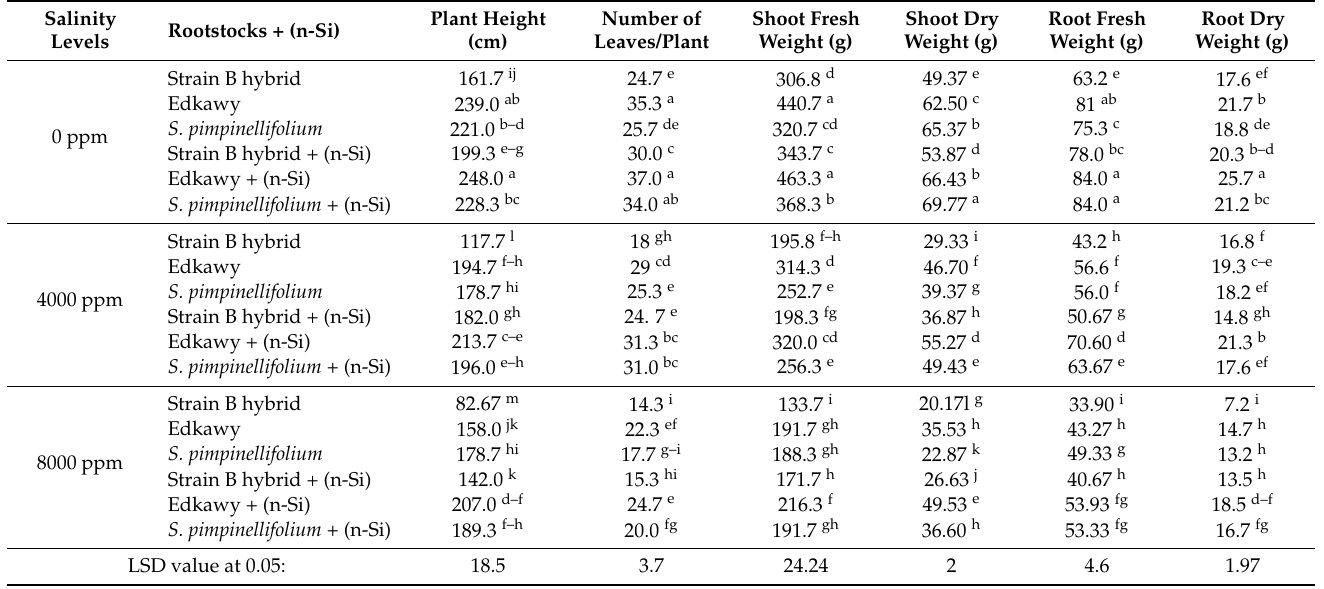
Table 1. Effects of water salinity, grafting, foliar application of nano-silicon (n-Si), and their interac- tions on the vegetative growth of tomato plants (combined 2020 and 2021